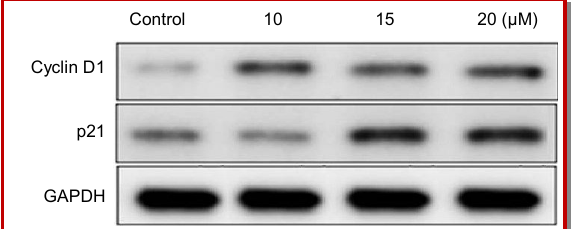
Figure 5: Zerumbone treatment induced expression of cyclin D1 protein in DU-145 cells. The cells were treated with zerumbone for 48 hours and then subjected to Western blot analysis